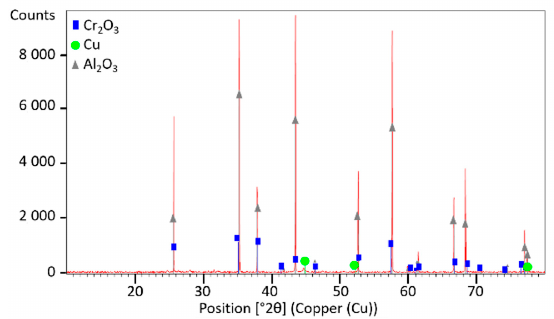
Figure 2. XRD analysis of 0.2–0.1 mm size fraction of photoresistors.